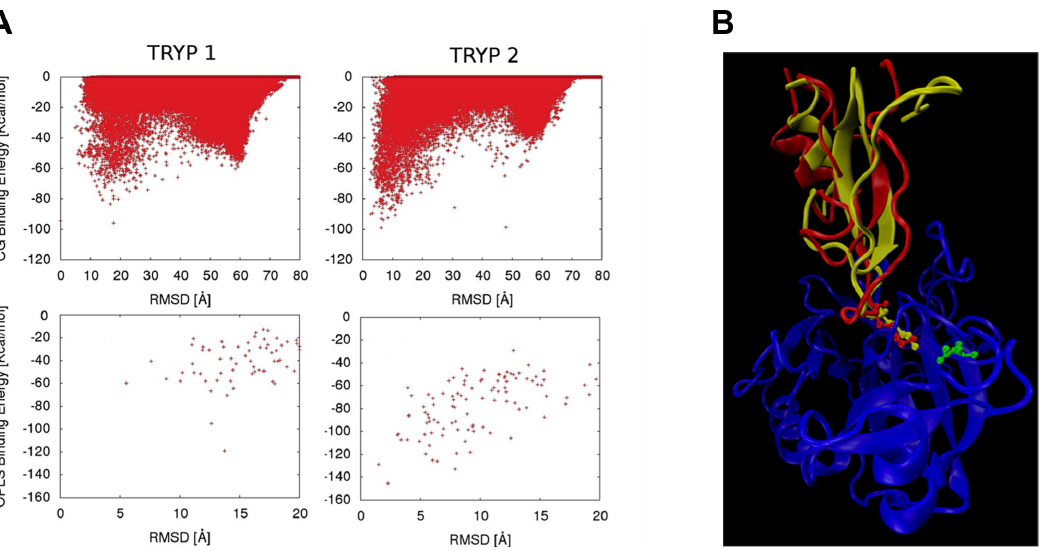
Figure 7. A–B. Coarse grain docking of refined tryptogalinin model and tryptogalinin-trypsin complex. Top two panels (A) show the coarse grain binding against the RMSD for two tryptogalinin models, Tryp1: the last snapshot of a 62 ns equilibration, and Tryp2, the snapshot with best superimposition to TdPI (its complex with trypsin) (PDB: 2UUY). RMSD were obtained with respect to the superimposition of tryptogalinin to 2UUY. Bottom panels show the all-atom binding energy after clusterization of the coarse grain poses. A comparison between (B) the best all-atom model for tryptogalinin (yellow) and the complex TdPI-trypsin crystal structure (PDB: 2UUY) (red) depict significant binding similarities. Lys13 and 34, and Asp191 (green) are represented in ball and stick.